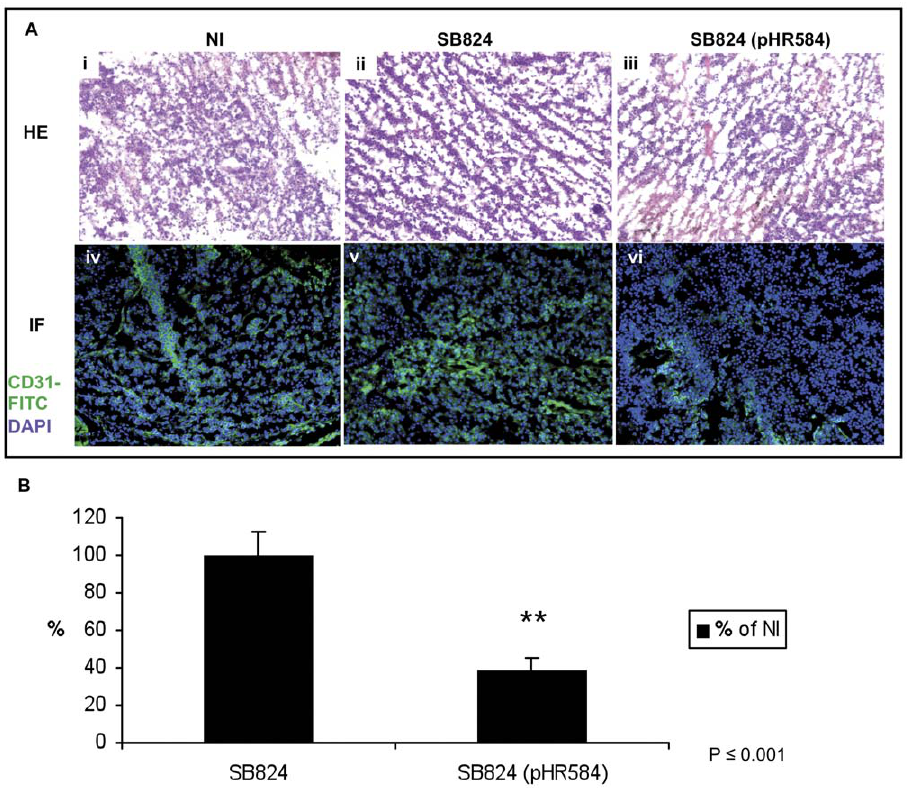
Figure 4. Vaccination with Salmonella SB824 (pHR584) leads to reduced angiogenesis in the melanoma flank tumor model. A On day 44 of the experiment, melanoma tumors of five mice were removed, prepared for histological analysis and stained with HE (i–iii). Additionally, tumor sections were stained with a FITC-conjugated CD31 antibody (green) and DAPI (blue), and analyzed by immunofluorescence microscopy (iv–vi). Representative images of tumor sections from three experimental groups are displayed. B Quantification of the area of the green FITC-fluorescence was performed using Cell ‘ P software (Olympus). The mean areas of CD31-FITC fluorescence from tumor sections of experimental groups SB824 and SB824 (pHR584) are shown as fraction of the mean area of CD31-FITC fluorescence from tumor sections of the non-immunized control group in %. Asterisks indicate values that differ significantly from the corresponding values obtained from mice of both control groups (**, p # 0.001). Each experiment was performed at least twice with similar results.